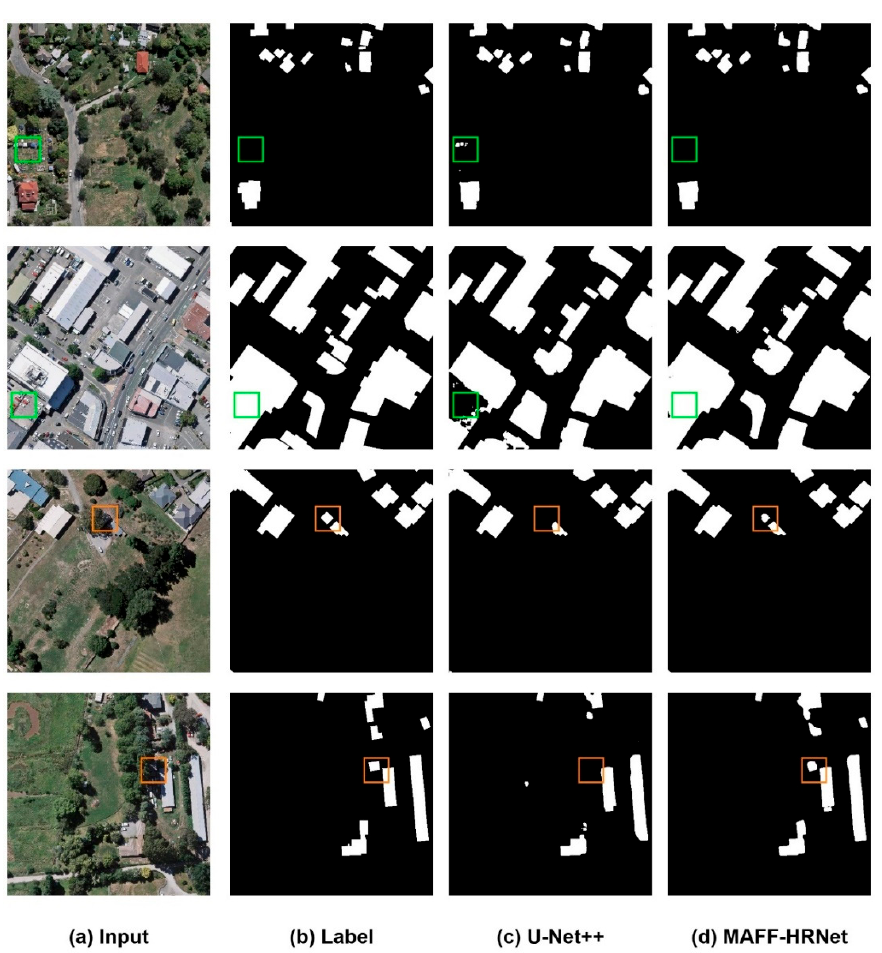
Figure 9. Experimental results on the WHU Building Dataset. ( a ) Original images. ( b ) Image labels. ( c ) U-Net++ results. ( d ) Results of our model. Table 2. Evaluation results on the WHU Building Dataset. The symbol “-” means that a correspond- ing result is not given for this method in its associated paper.